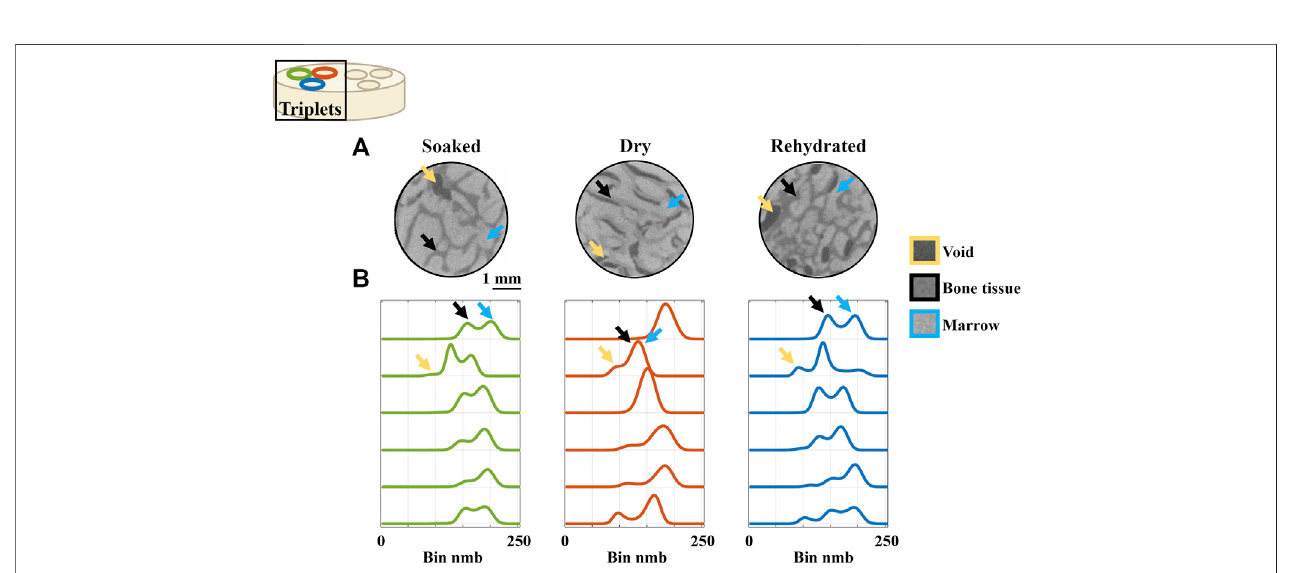
FIGURE 4 | Histograms of the neutron tomography images of the trabecular bovine bone plugs. (A) Transverse slices of representative specimen from each hydration group. (B) Specimen-speci fi chistograms. Each linecorresponds toone specimen ( n = 6per hydration group). Each row corresponds toone triplet, i.e., plugs extracted next to each other from the same anatomical location. Arrows indicate peaks corresponding to void (yellow), bone tissue (black), and marrow (blue).